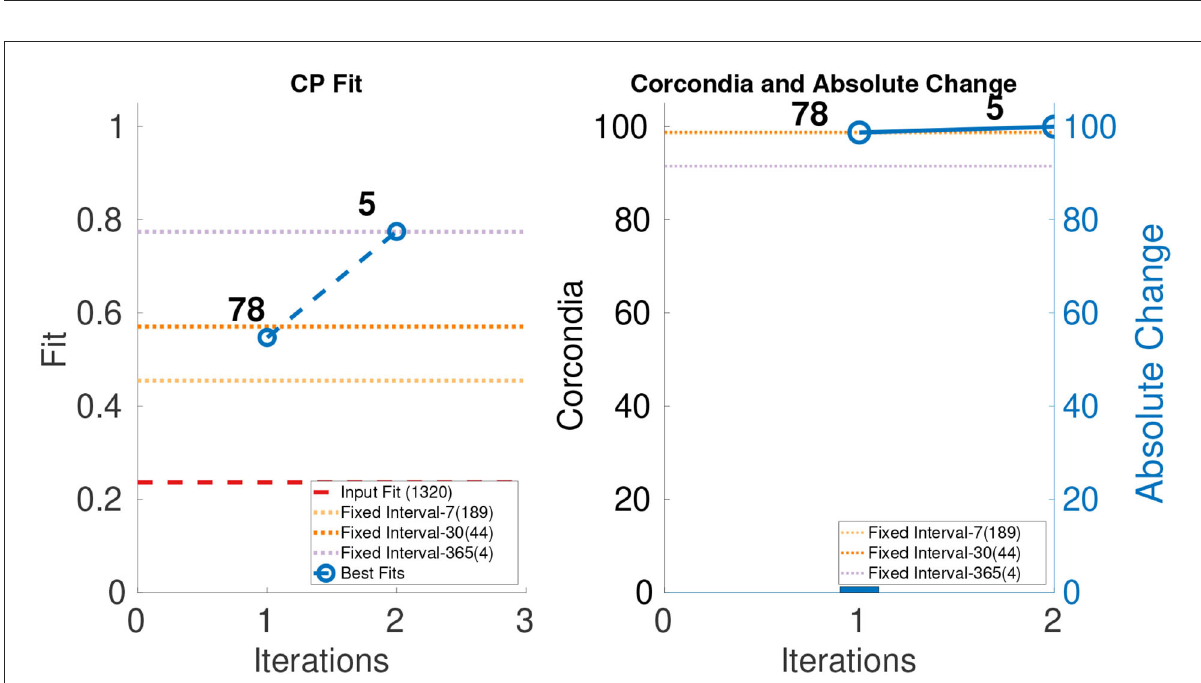
FIGURE6 CP fit and CORCONDIA of best fit tensor and its absolute change at each iteration for Enron Daily.